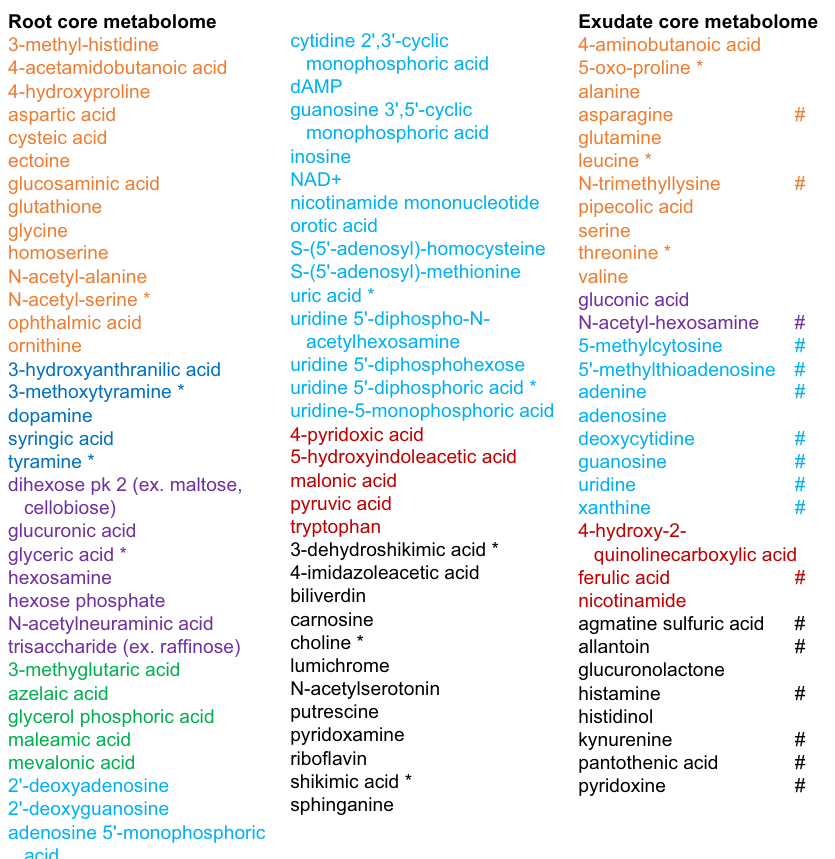
Fig. 6 | Core metabolites in roots and exudates. Metabolites detected in A. thaliana, B. distachyon , and M. truncatula roots or in roots as well as exudates. Metabolites are colored by class: orange: Amino acids, peptides and derivatives, purple: carbohydrates and conjugates, green: lipids and lipid-like, blue: